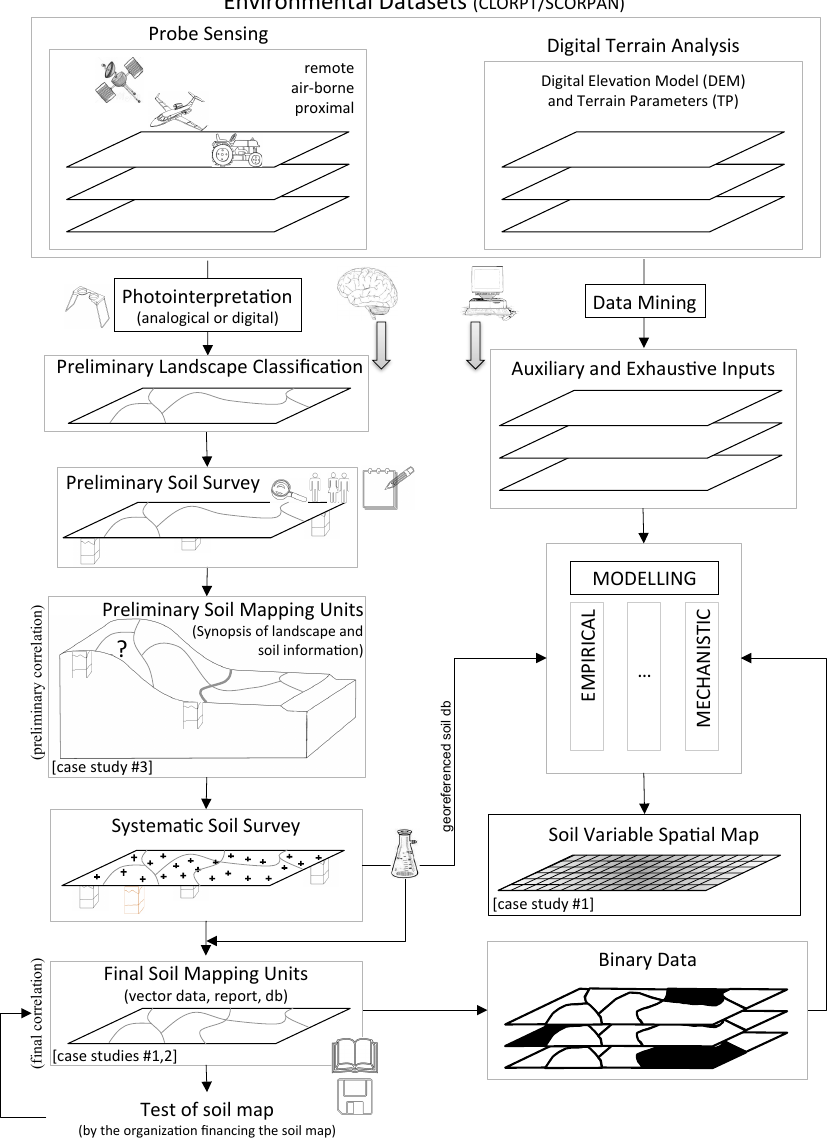
Fig. A1. Data flow of the main steps involved in both conventional (left panel) and digital (right panel) soil mapping. Some remarks: (i) the same set of environmental data can be used for conventional or digital soil mapping; (ii) to promote understanding the two mapping procedures are separately depicted with few key interaction points (e.g. lab data are used to calibrate SCORPAN like models and to co-define